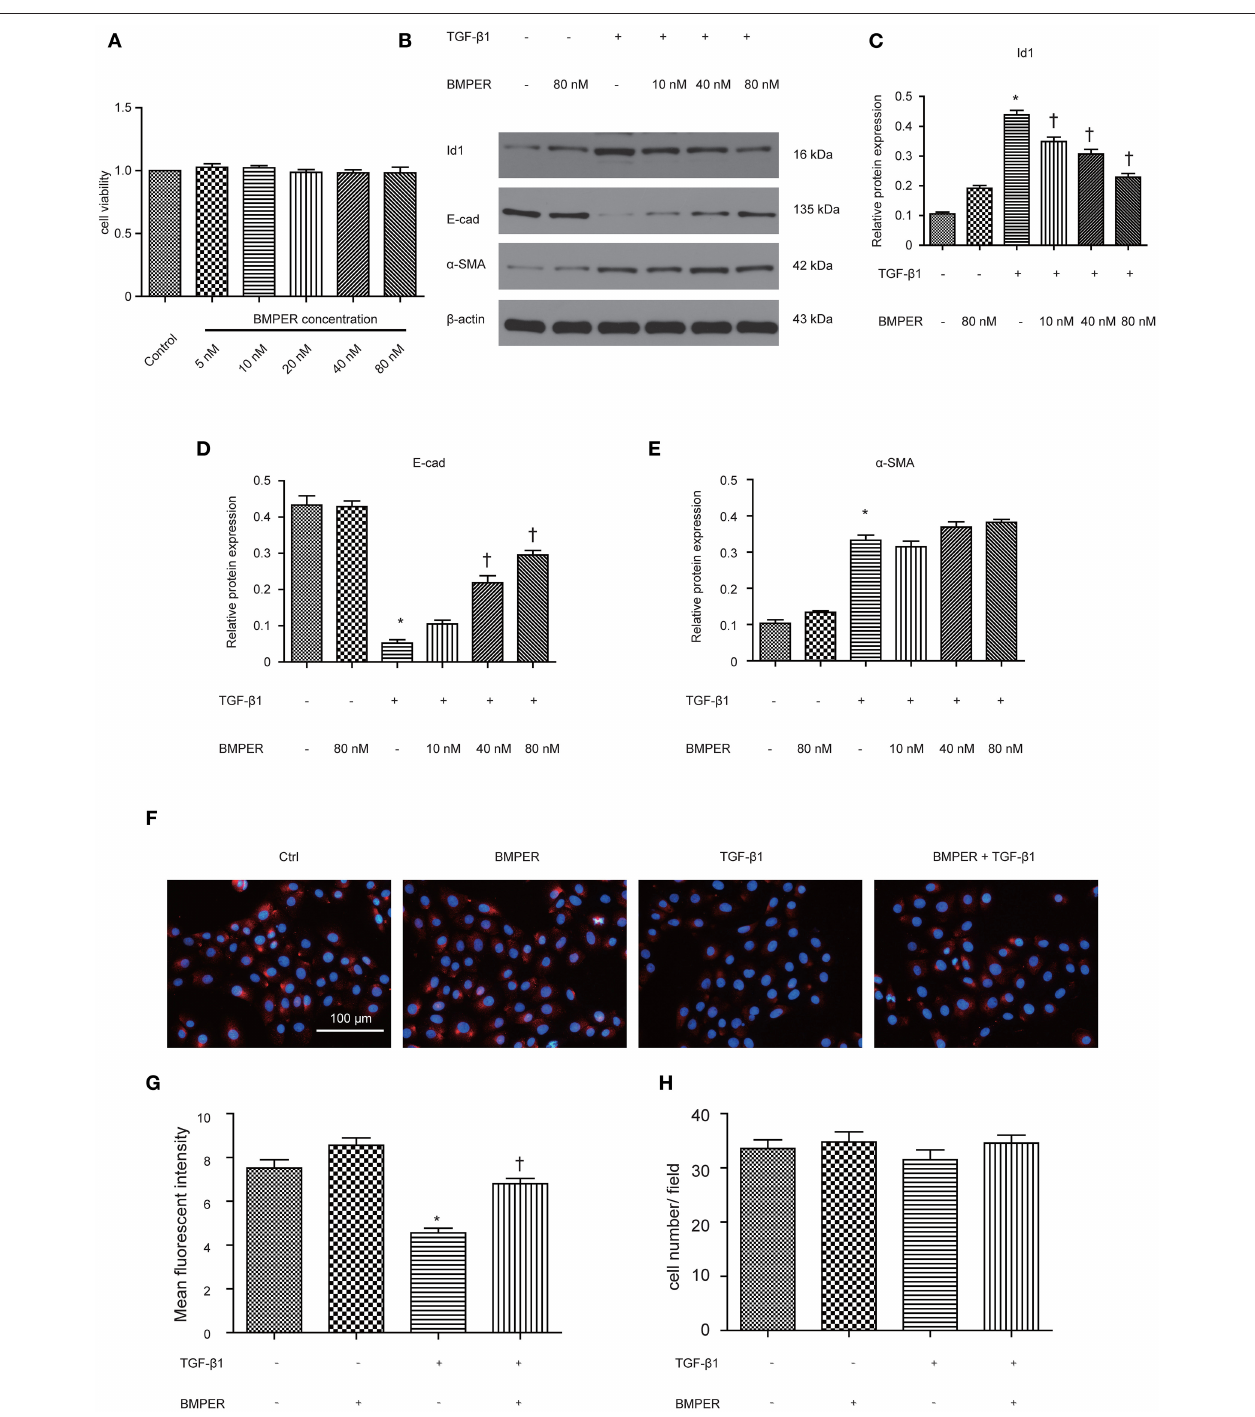
FIGURE 3 | Exogenous BMPER inhibited TGF- β 1-induced dedifferentiation in HK-2 cells. HK-2 cells were incubated with increasing amounts of BMPER (5–80 nmol), and cell viability was detected by MTT (A) . HK-2 cells were treated with 10ng/ml TGF- β 1 and increasing amounts of BMPER as indicated for 48h, and the protein expression for Id1, E-cadherin and α -SMA was measured by Western blot (B) . The relative protein expression for Id1, E-cadherin and α -SMA in HK-2 cells was displayed (C–E) . Values are the means ± SEM ( n = 3). Representative photographs for E-cadherin in HK-2 cells after various treatments were displayed by immunofluorescence staining (F) . Graphic presentation of mean fluorescent intensity in various groups (G) . Neither treatment modalities significantly affected HK-2 cell counts (H) . Cell numbers were counted after various treatments for 48h. Scale bar = 100 µ m. * p < 0.05 vs. control; † p < 0.05 vs. TGF- β 1 group.